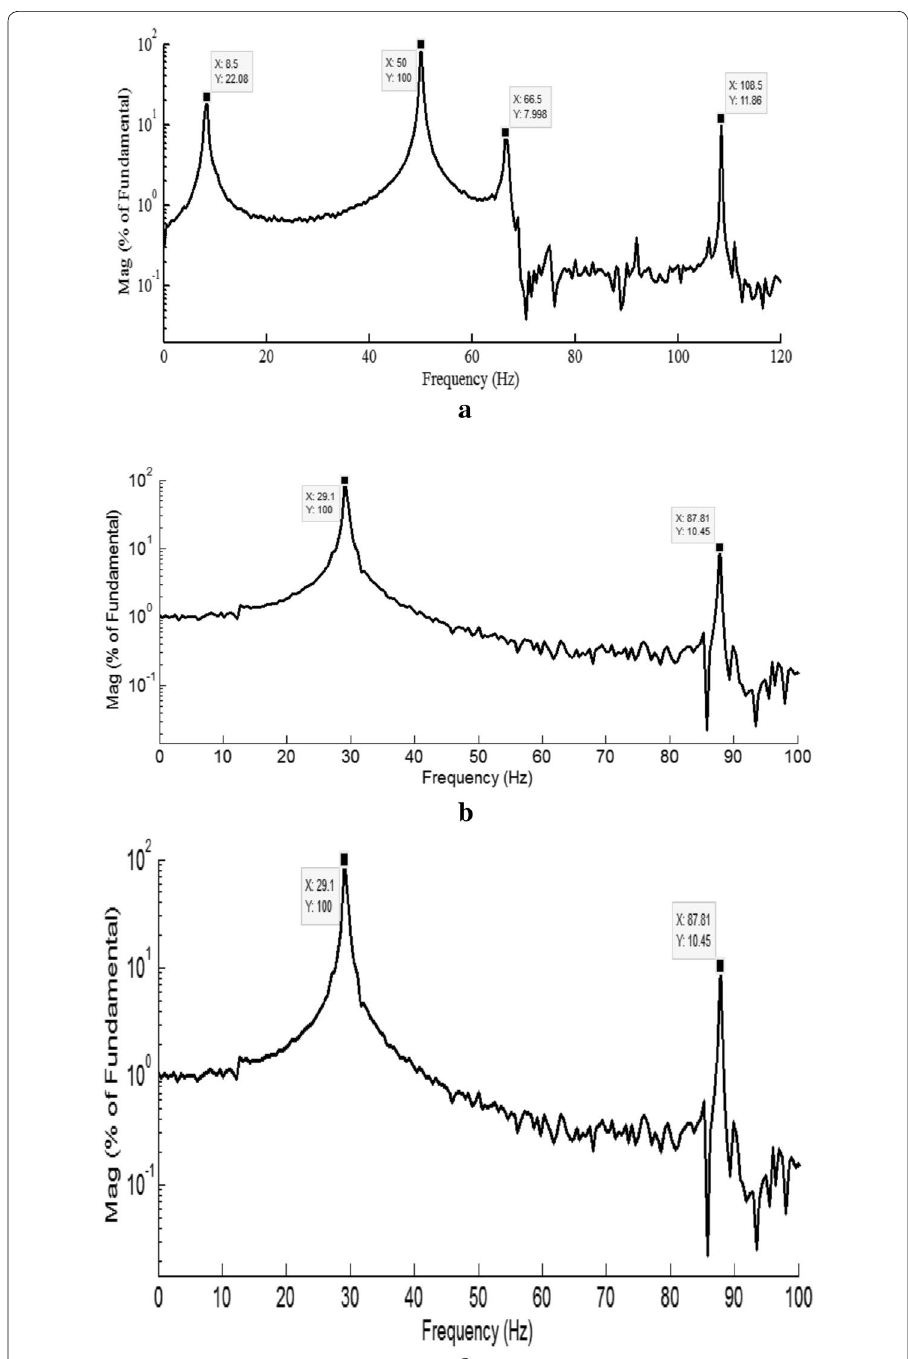
Fig. 12 Current spectrums for isolated neutral star connection, a stator phase current, b rotor (phase‑ar) current and c rotor (phase‑br)